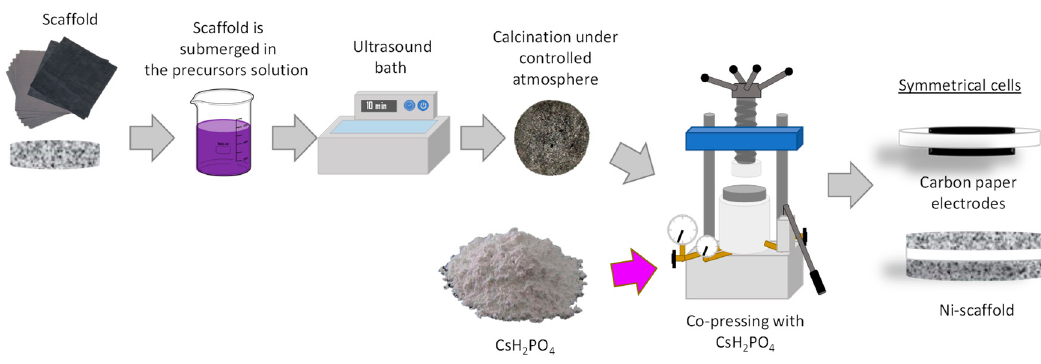
Figure 1. Main steps for symmetrical cells preparation.